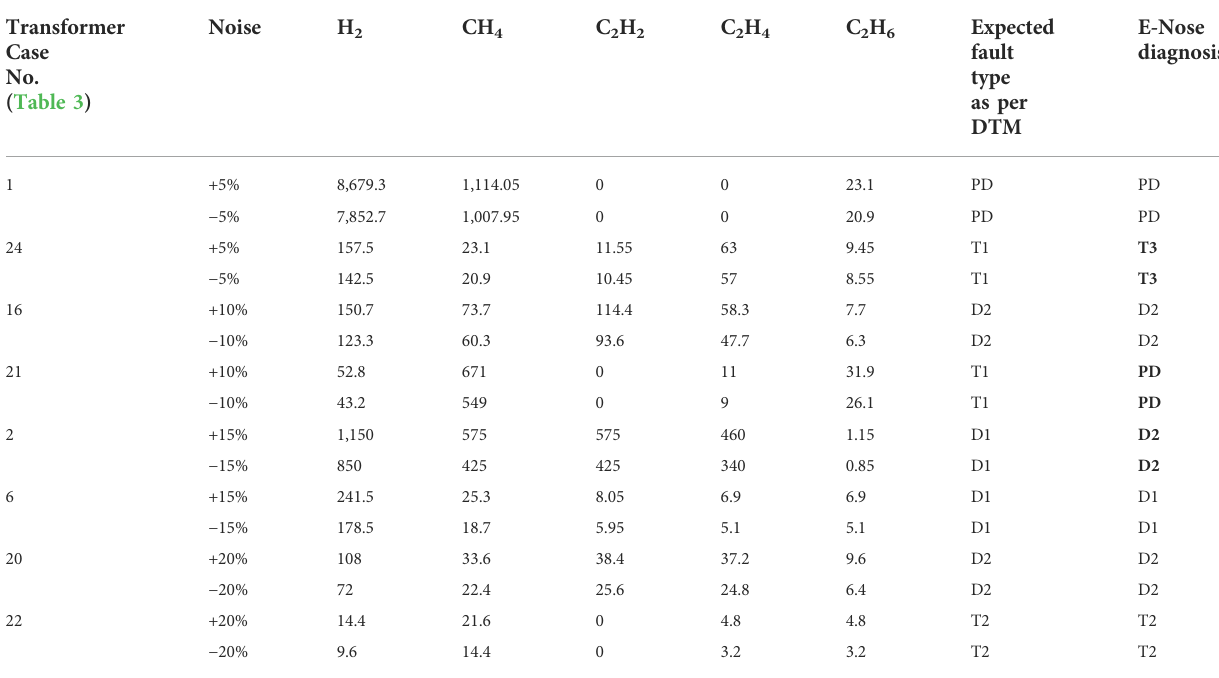
Bold values indicate deviation in diagnosis from expected or correct